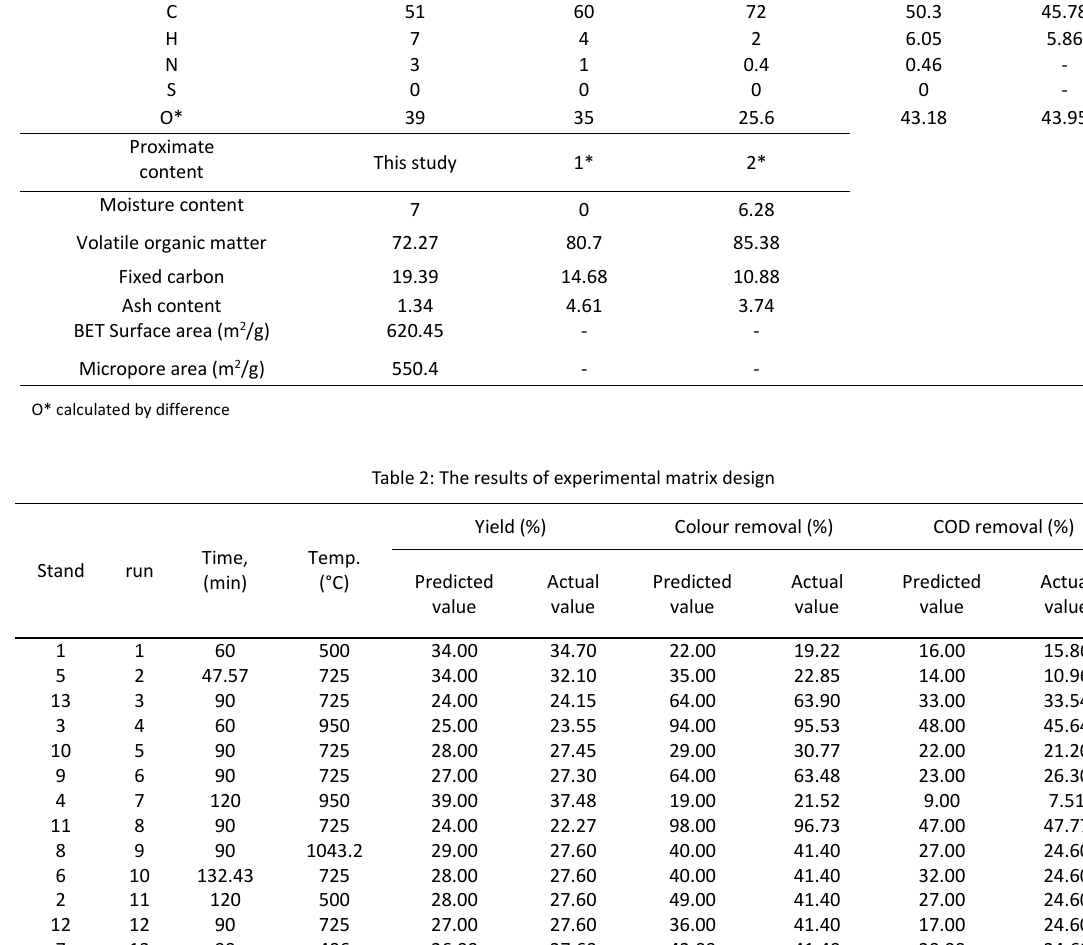
Table 1: Properties of raw OPKS, biochar and activated carbon and comparison with previous study (1* Chan et al., 2018; 2* Rueda-Ordóñe et al., 2019 ) This study Present element OPKS